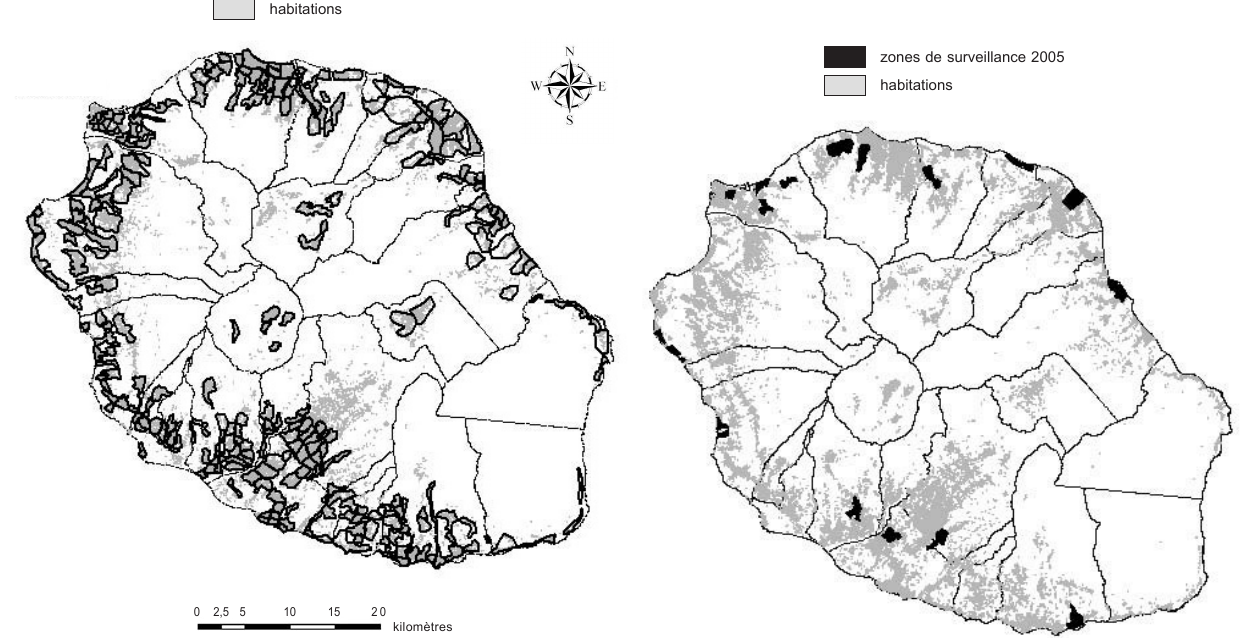
Fig. 3. – Localisation géographique des quartiers soumis à une démoustication.